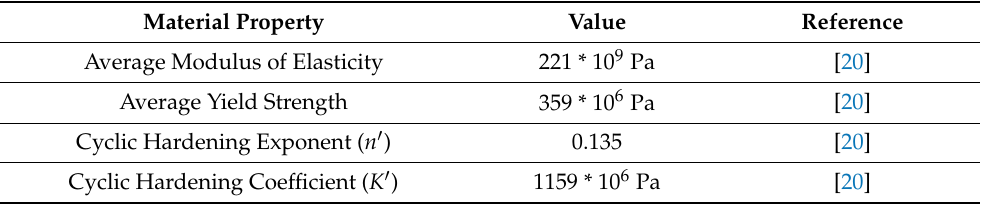
Table 4. Summary of the characteristic properties of high-strength iron-based